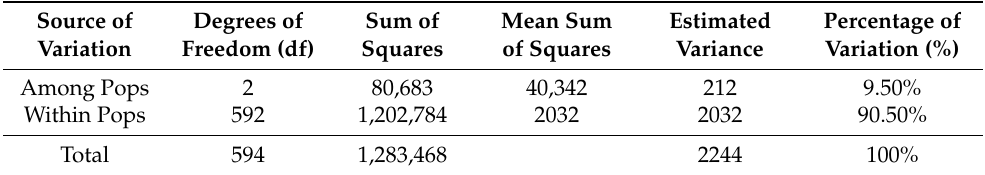
Table 3. The analysis of the molecular variance (AMOVA) among the three types of subpopulations based on the genome wide